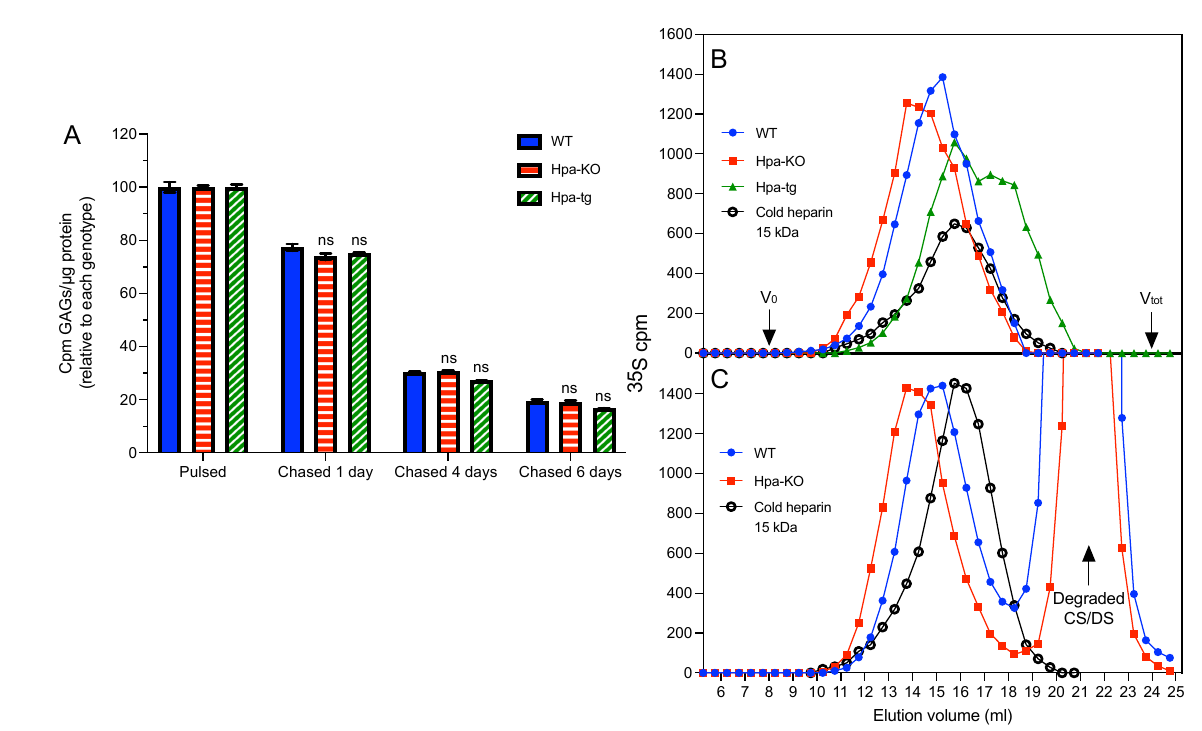
Figure 4. Effect of heparanase on catabolism of GAGs and heparin . ( A ) PCMC cultivated for seven weeks was metabolically labeled with 35 S for 4 hr and then chased for one, four, and six days, re- spectively. The 35 S-labeled total GAGs were purified, and the total radioactivity (cpm) was normal- ized for cellular protein content. Filled blue bars : WT; horizontally striped red bars : Hpa-KO; diagonally striped green bars : Hpa-tg. ( B ) Size analysis (Superose-6 column) of heparins isolated from PCMC immediately after 24 hr labeling and ( C ) after four days chasing. Blue circles : WT; red squares : Hpa- KO; green triangles : Hpa-Tg (note: only a minor amount of heparin was recovered after four-days chasing, which did not allow performance of this analysis). Unlabeled commercial 15 kDa heparin ( empty circles ) was included as an internal control. Values in ( A ) represent the mean of analytical triplicates plus/minus one standard deviation. Two-tailed, unpaired t -test, ns , not significant the comparison of Hpa-KO and Hpa-Tg vs. WT within each chasing time. The whole experiment was repeated two times with similar results.